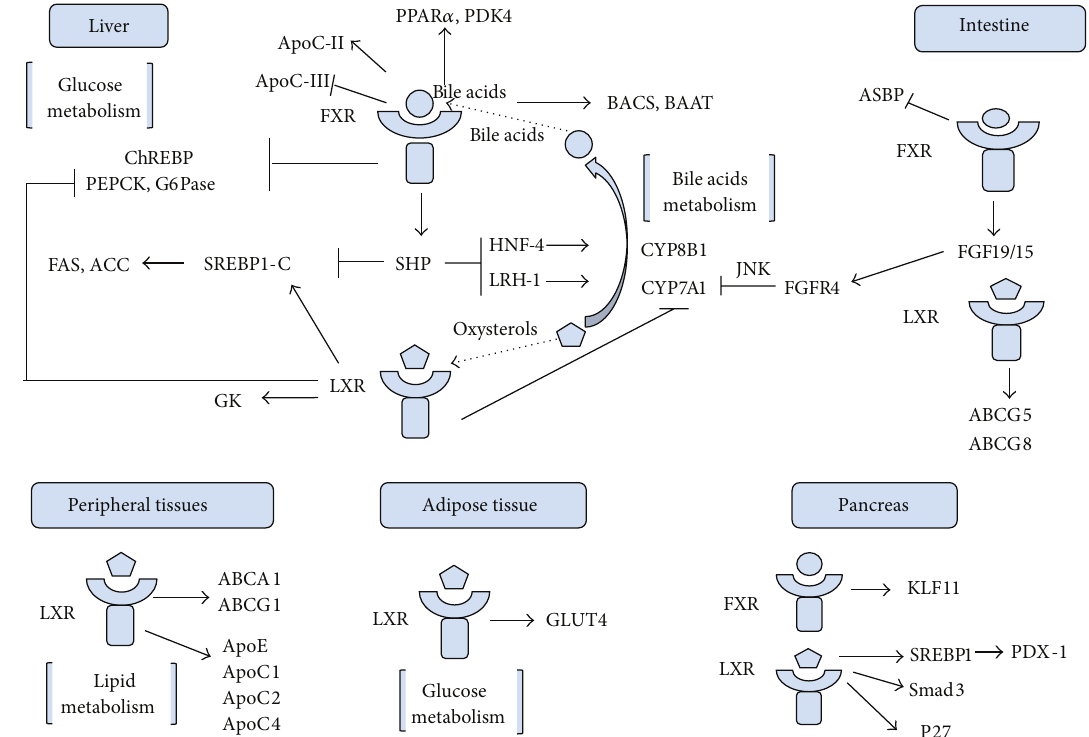
Figure 1: FXR and LXR target genes in bile acids, lipid, and glucose